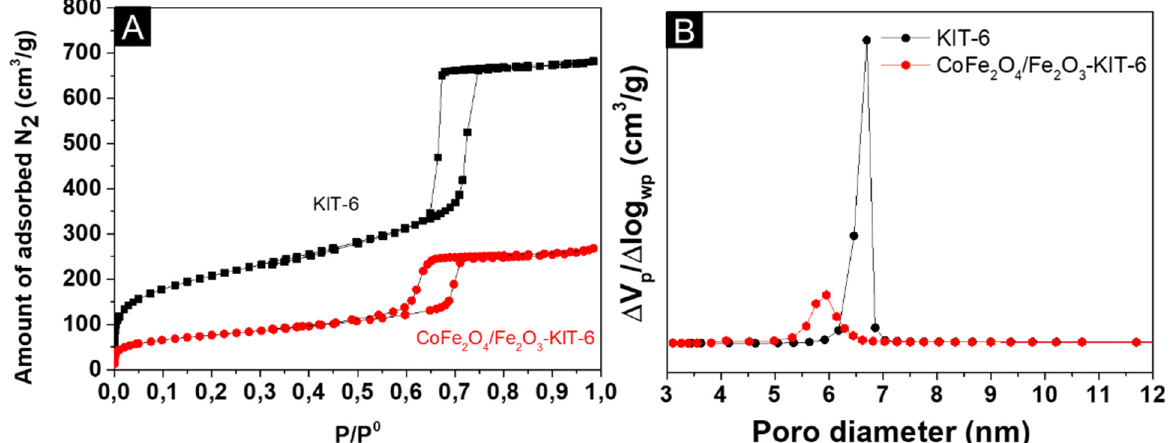
Figure 2. N 2 physisorption: ( A ) N 2 adsorption–desorption isotherms; ( B ) pore diameter distribution. The corresponding calculated textural parameters are listed in Table 1 for surface area (S BET ), pore volume (V p ), and pore diameter (D p ). Table 1. Textural parameters of the solids.